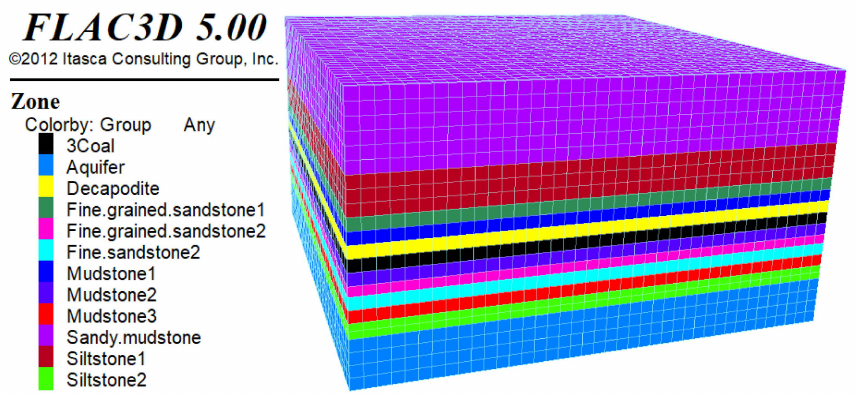
Figure 7. Three-dimensional geological